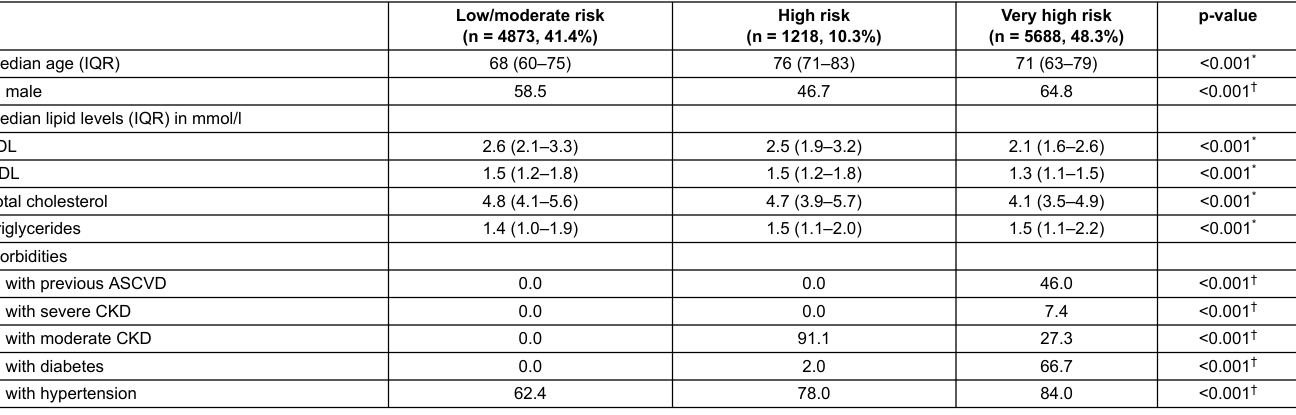
Table 1: Patient characteristics by cardiovascular risk.